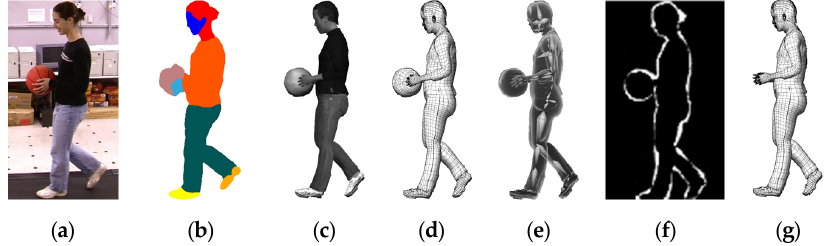
Figure 9. Advantage of 3D body estimation by virtual dressing: ( a ) 2D gait image with a ball carrying, ( b ) semantically parsed image of ( a ), ( c ) estimated 3D gait model with a similar carrying condition of ( a ), ( d ) 3D body mesh of ( c ), ( e ) skeletons information of ( c ), ( f ) silhouette di ff erence between ( b ) and ( c ) and ( g ) 3D body mesh with the ball